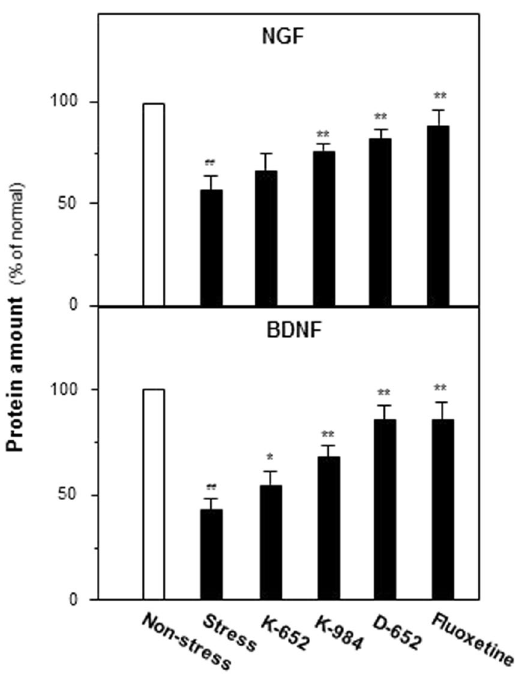
Figure 3. Effect of KXS series formulae treatment on expressions of neurotrophic factors in hippocampus of CUMS-treated mice by ELISA analysis. The treatment of KXS series formulae and fluoxetine in the mice were same as that in Fig. 1. The hippocampus tissues were collected after four-week treatment and the amounts of NGF were analyzed by ELISA kits. Comparisons between groups were carried out by a one-way ANOVA followed by a post-hoc Bonferroni test. Values are expressed in the percentage of non-stressed group as Mean ± SEM (n = 8). # p < 0.05, ## p < 0.01 (compared with non-stressed group); * p < 0.05, ** p < 0.01 (compared with stressed